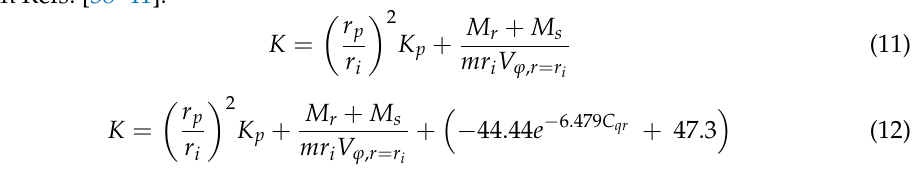
9 of 24 Figure 4. Radial distribution of core swirl ratio in C1 cavity at different Re : ( a ) Re = 2.3793 × 10 5 , ( b ) Re = 4.7586 × 10 5 , ( c ) Re = 7.1379 × 10 5 , and ( d ) Re = 9.5172 × 10 5 . The distribution of K in the C3 cavity is shown in Figure 5. Above the receiving hole,